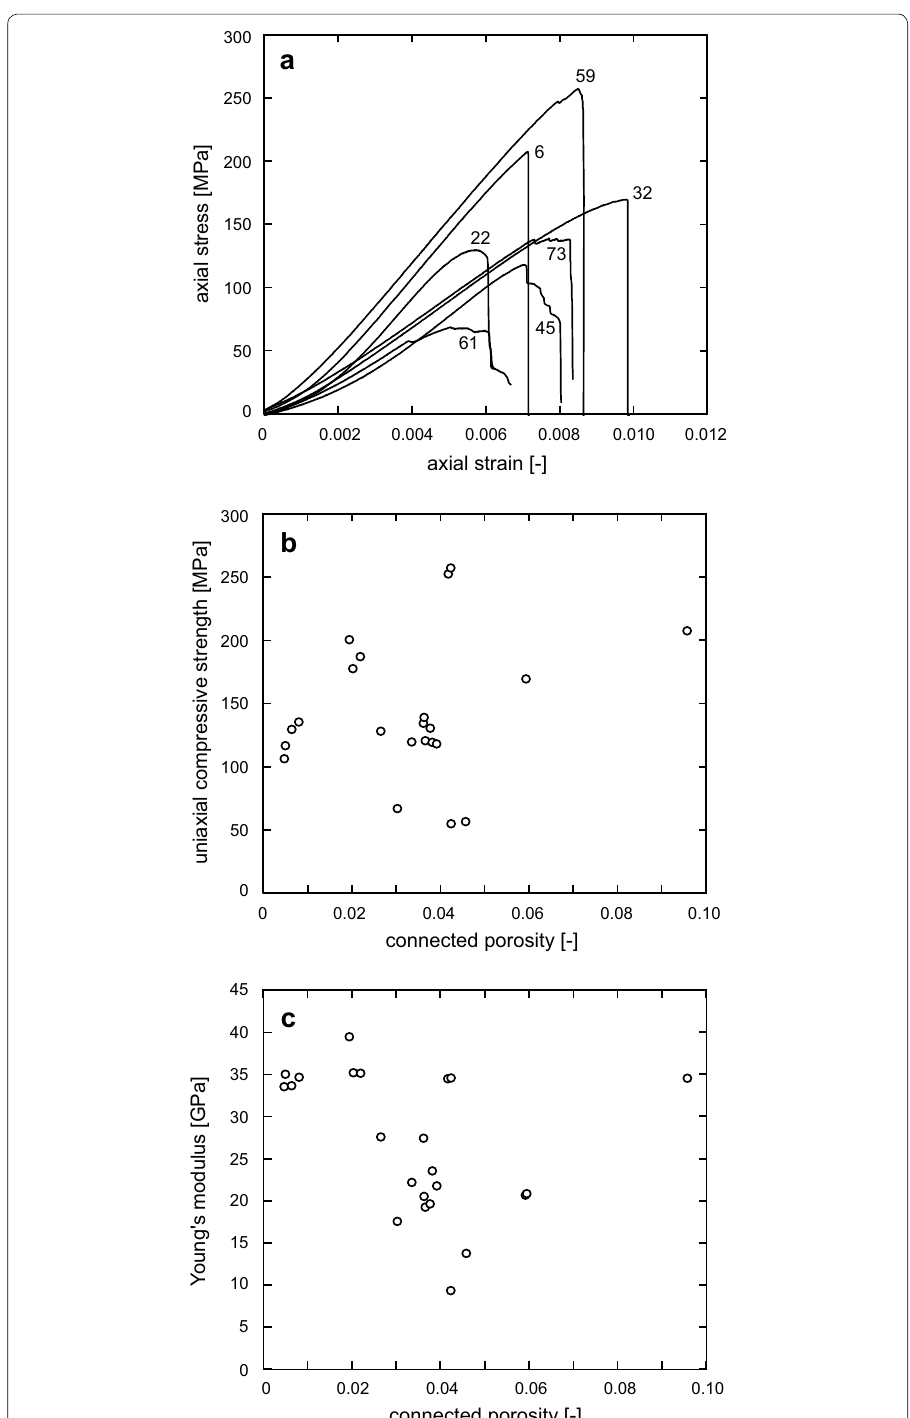
Fig. 8 a Representative dry stress–strain curves (box number indicated next to each curve), b dry uniaxial compressive strength as a function of connected porosity, and c dry Young’s modulus as a function of connected porosity for Muschelkalk samples from exploration well EPS-1